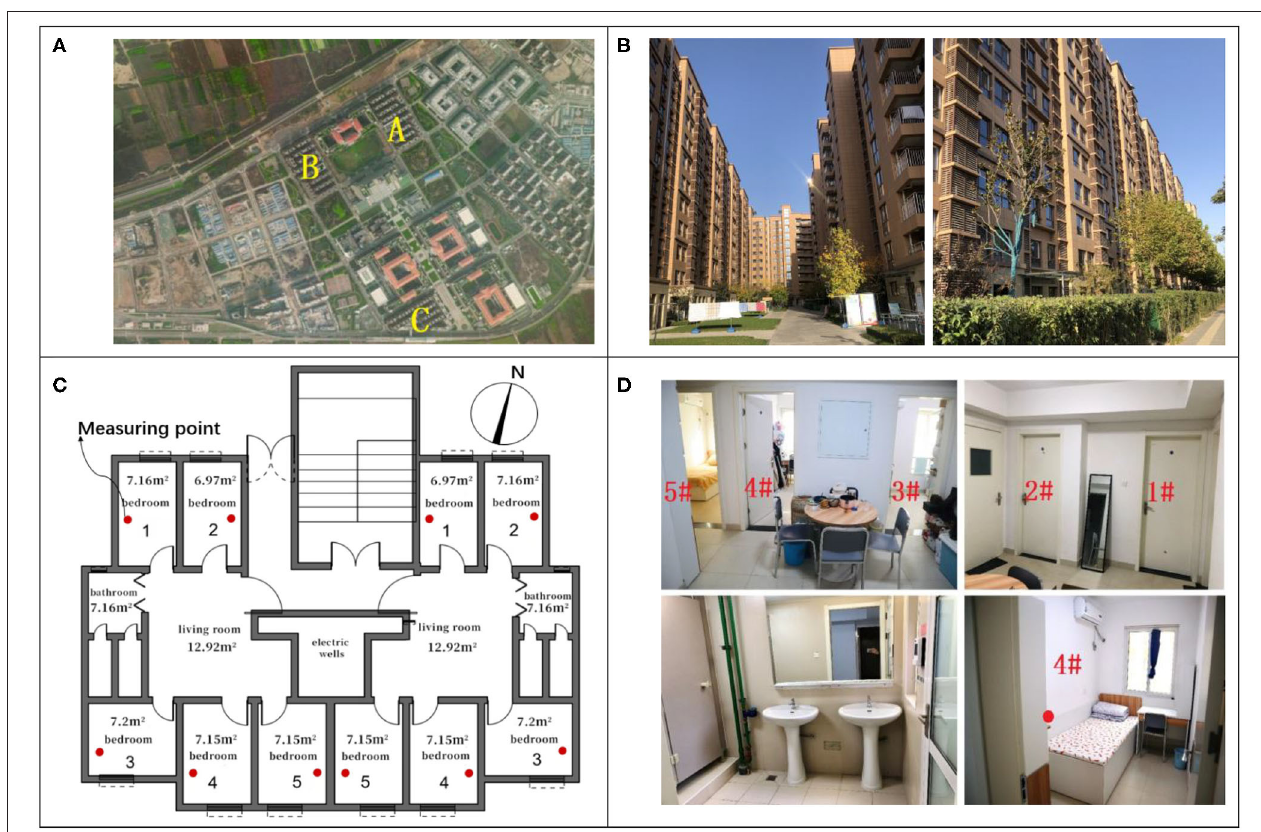
FIGURE 1 | Unit-type student apartment in the innovation harbor. (A) Three apartments. (B) Apartment Photos. (C) Apartment plan. (D) Internal photos.